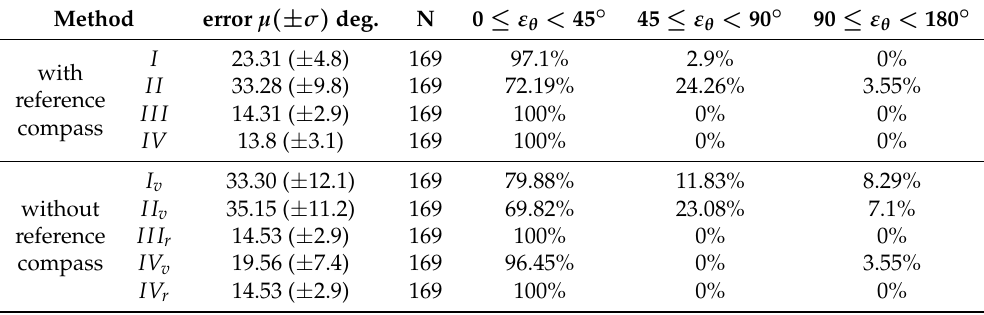
Table 3. Angular errors with various methods for Vardy’s image set; testing methods are described in Table 1 ( N is the number of testing points, µ the average of angular errors and σ the 95% confidence